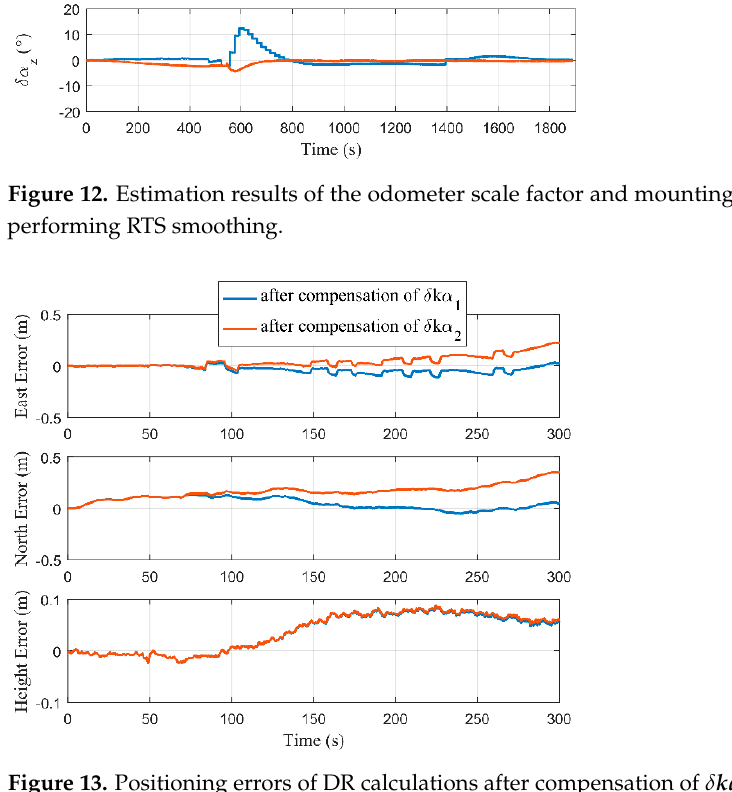
Figure 13. Positioning errors of DR calculations after compensation of